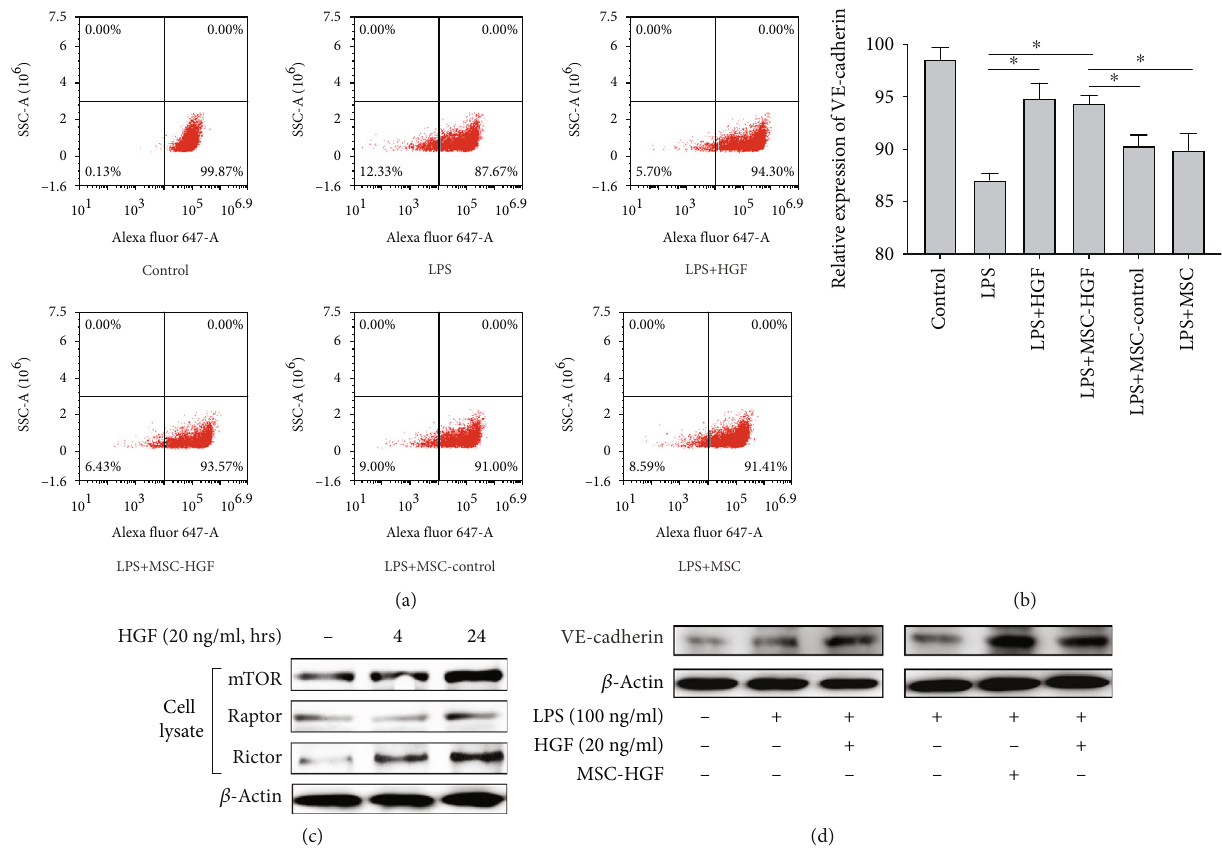
Figure 1: E ff ects of MSC-secreted HGF on LPS-induced PMVEC barrier. We used 24 h transwell coculture transwell system for culturing PMVECs with MSC, overexpression HGF of MSC (MSC-HGF), or HGF negative control of MSC (MSC-control). Moreover, PMVECs were treated with HGF (20 ng/ml), with or without stimulation with LPS (100ng/ml) for 4 h and 24h. (a) Flow cytometry scatter plot of 4h VE- cadherin expression with MSC-secreted HGF in LPS-induced PMVECs. (b) Flow cytometry cell counts (%) of 4 h VE-cadherin expression with MSC-secreted HGF in LPS-induced PMVECs. (c) The e ff ect of HGF (20 ng/ml) to LPS-induced PMVEC endothelium lysate tested by western blot with 0.4 and 24h. (d) VE-cadherin protein expression change with MSC-secreted HGF in LPS-induced PMVECs tested by western blot with 24h. Results are mean ± SD ( n = 3 ). ∗ p < 0 : 05